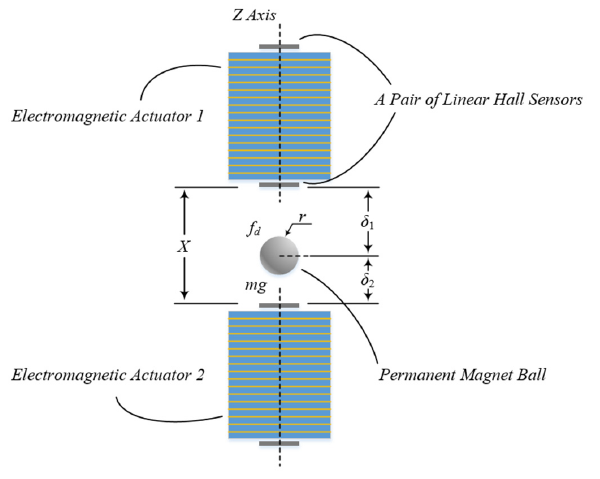
Figure 3. External magnetic actuation model of dual electromagnetic actuators.